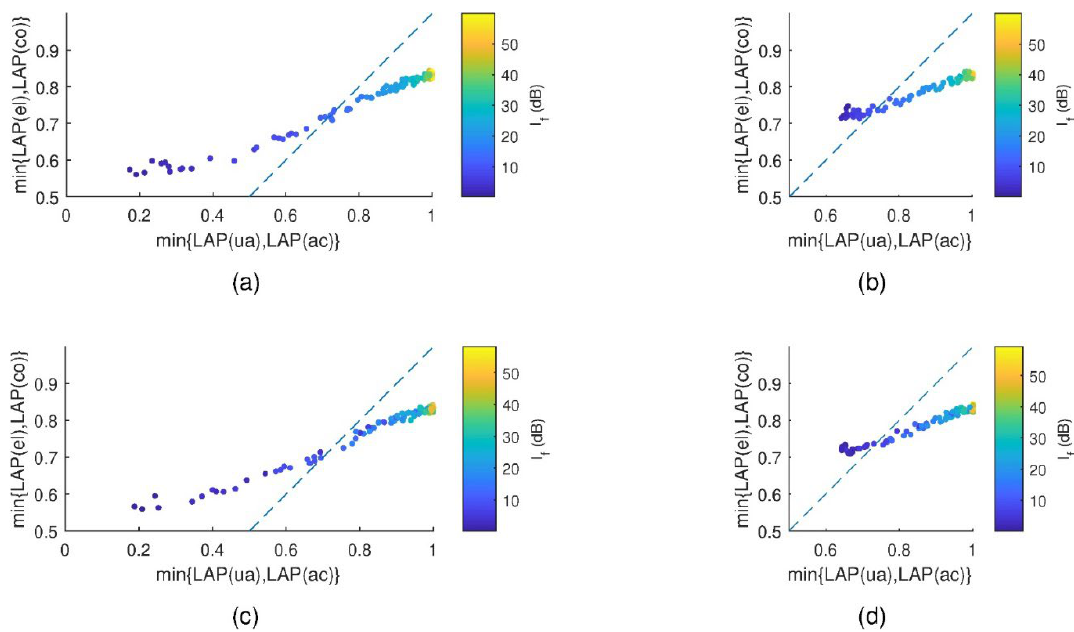
Figure 12. Minimum LAP achieved with (y-axes) and without (x-axes) implantation. The dashed lines are the lines of equality. The flat component of IHCL is color-coded. The shown types of hearing losses are as follows: ( a ) IHCL only, ( b ) CGL and IHCL, ( c ) IHCL + CS, and ( d ) CGL + IHCL + CS.